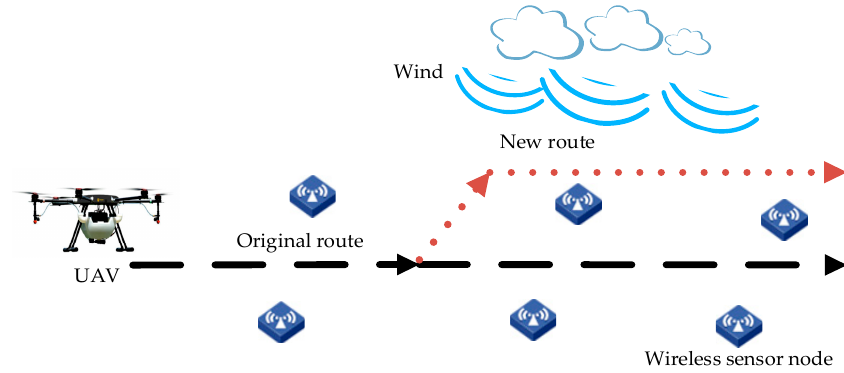
Figure 1. UAV spraying route changed based on ground sensor data.